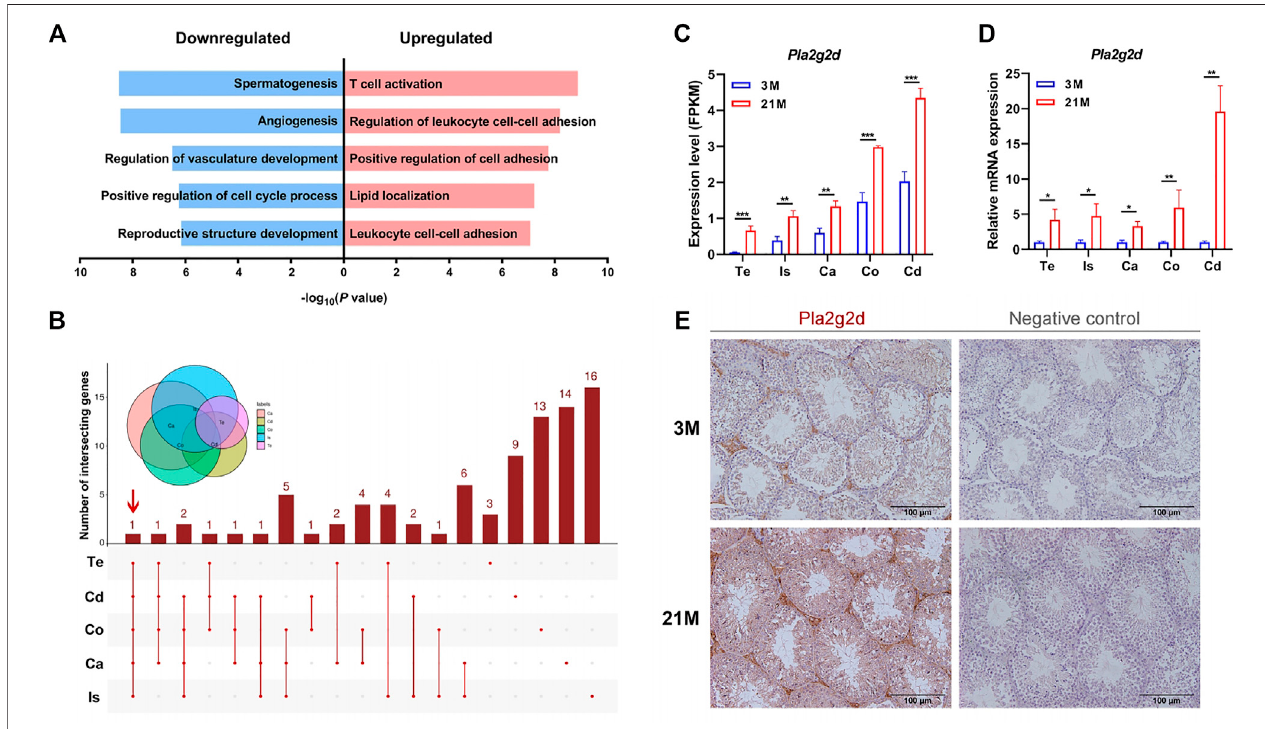
FIGURE 5 | Pla2g2d as a candidate biomarker for male reproductive aging. (A) Gene Ontology enrichment analysis of age-related DEGs in the testis and epididymis. (B) UpSet plot of the intersection of upregulated DEGs related to “ T cell activation. ” (C) Expression patterns of Pla2g2d in the testis and four regions of the epididymisfromRNA-seq dataand validatedby (D) qPCRin3-month-old( n (cid:2) 6)and21-month-old( n (cid:2) 6)mice. (E – I) Theexpression ofPla2g2d increasedwithage,as determined by immunohistochemistry in mouse (E) testis and by immuno fl uorescence staining in (F) the initial segment, (G) caput, (H) corpus, and (I) cauda. (J) PLA2G2D mRNA levels in human seminal plasma samples ( n (cid:2) 145) at different ages validated by qPCR. PLA2G2D mRNA levels were evaluated by the delta Cycle threshold ( Pla2g2d minus β -actin). (k) PLA2G2D protein expression in human seminal plasma samples ( n (cid:2) 40) validated by ELISA. * p < 0.05, ** p < 0.01, *** p <